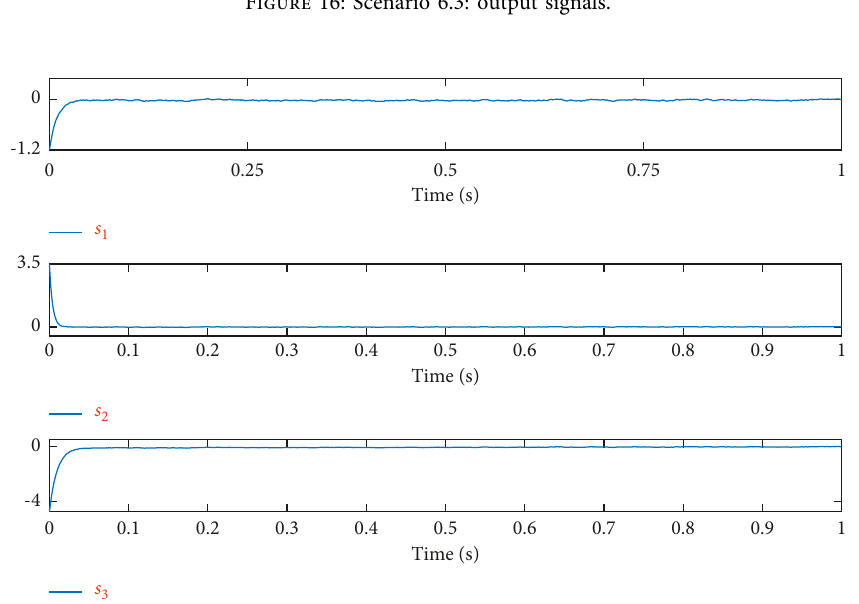
Figure 16: Scenario 6.3: output signals.